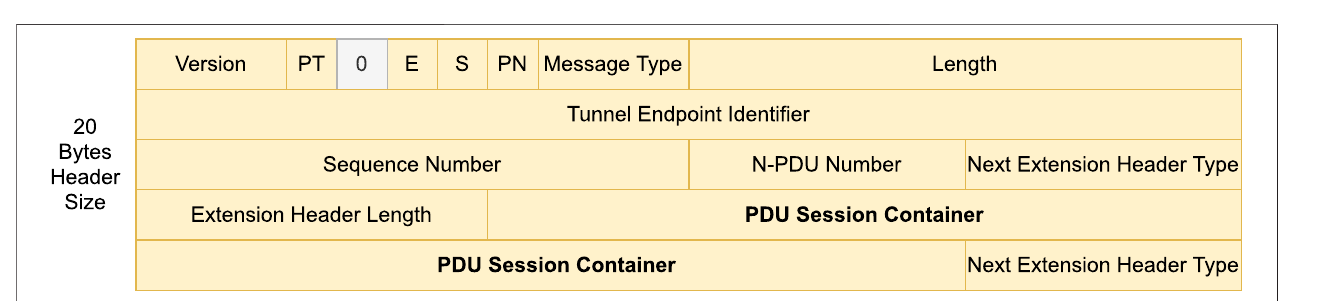
FIGURE 6 | TCP throughput measurements on the forward link (static scenario).